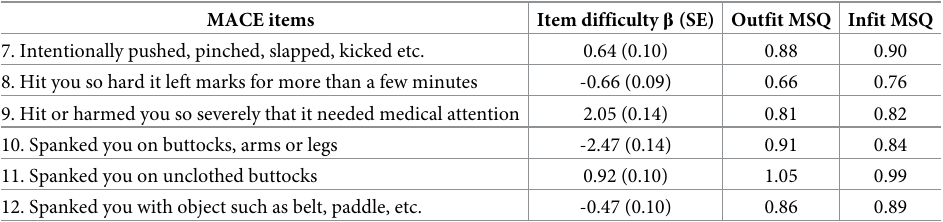
Table 1. Rasch analysis of parental physical maltreatment